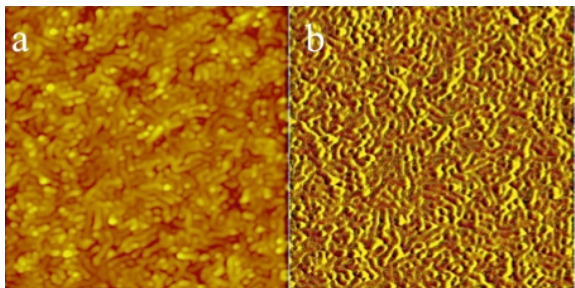
Figure 5. AFM height ( a ) and phase ( b ) images for thin films prepared from the PS- b -P4VP/HNA mixture (4VP/HNA 1:1 molar ratio) at a concentration of 2 wt % in 1,4-dioxane (images are 3 × 3 μ m 2